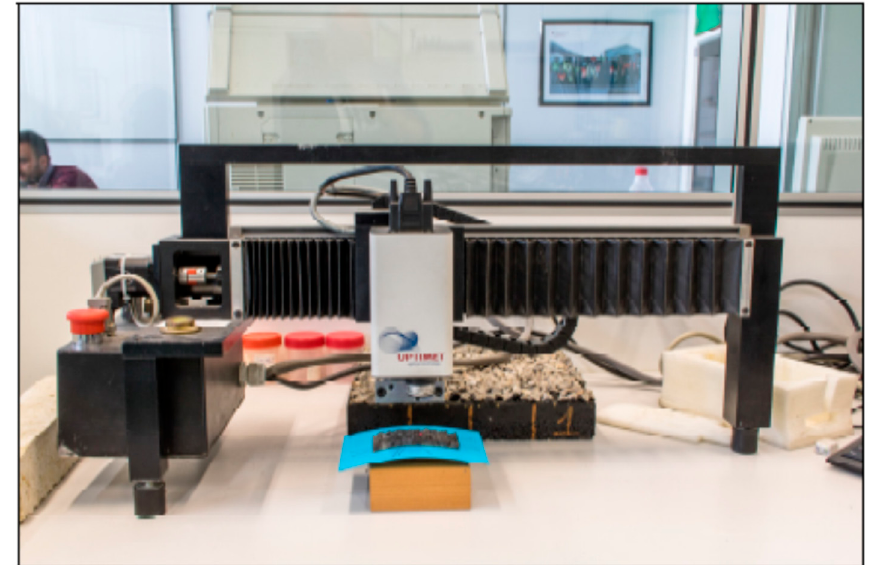
Figure 3. Contactless laser profilometer.